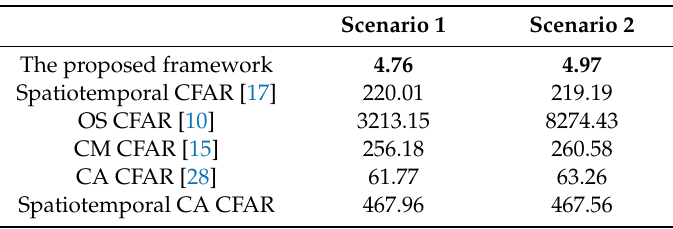
Table 4. Elapsed time of the